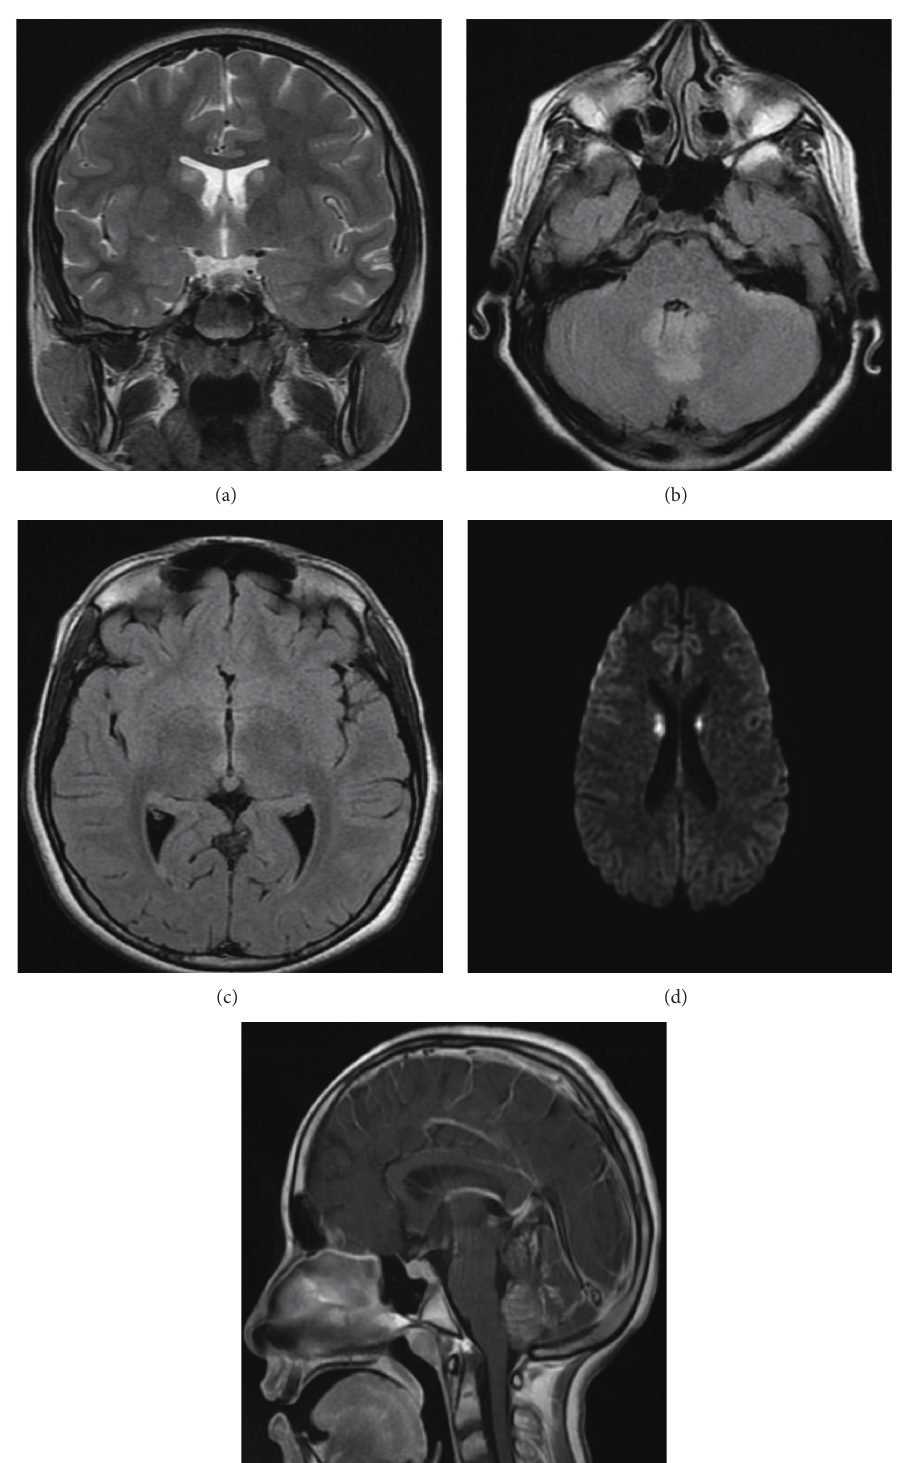
Figure 2: Magnetic Resonance Images performed during the second episode. (a) T2 coronal images showing hyperintense signals in caudate nuclei bilaterally. (b)-(c) Axial FLAIR images showing hyperintense signals in vermis and periaqueductal areas. (d) Axial DWI showing restricted diffusion in caudate nuclei. (e) Sagittal T1 with contrast images showing enhancement of the